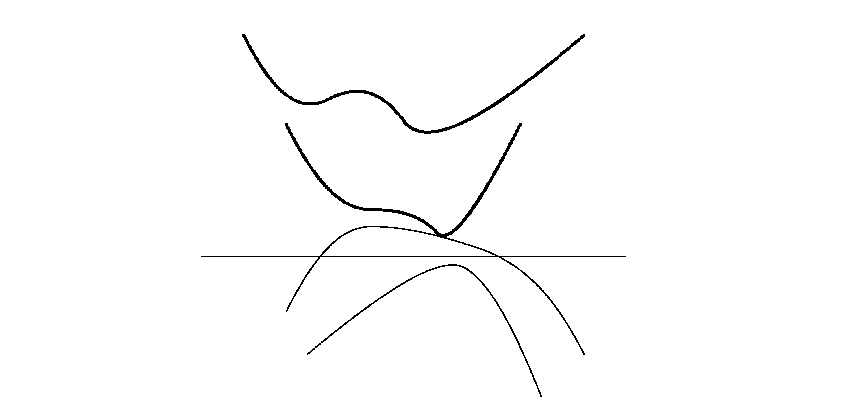
contour avoiding s